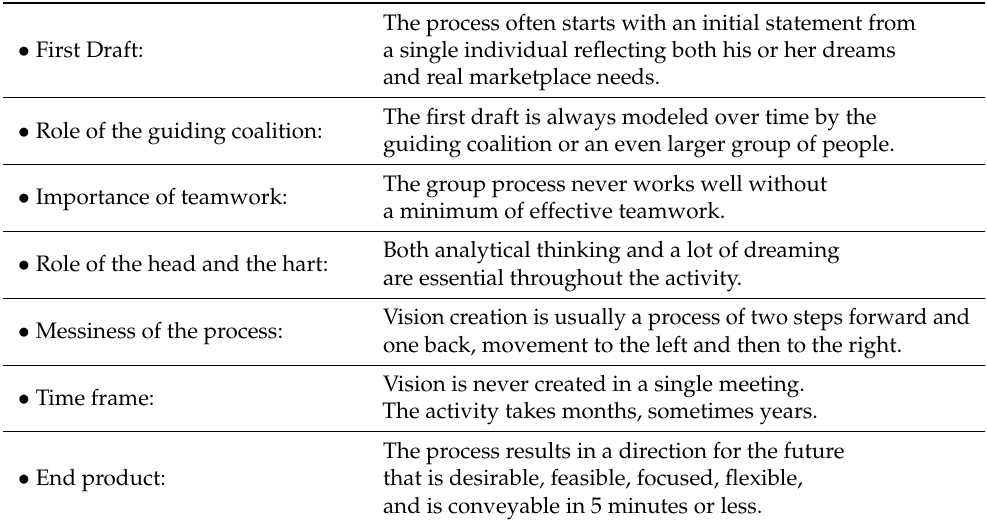
Table 2. Creating an Effective Vision, own table following